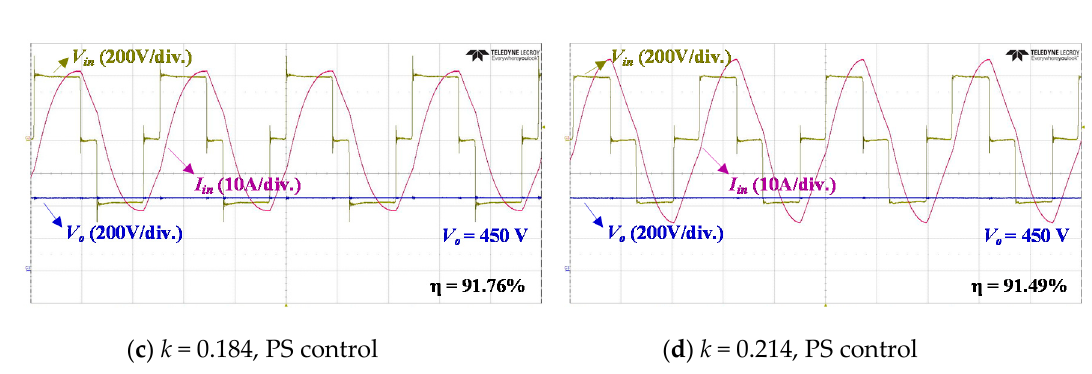
Figure 10. Experimental waveforms of the proposed control at P batt = 3.3 kW. Table 3. Specifications of the experimental setup.